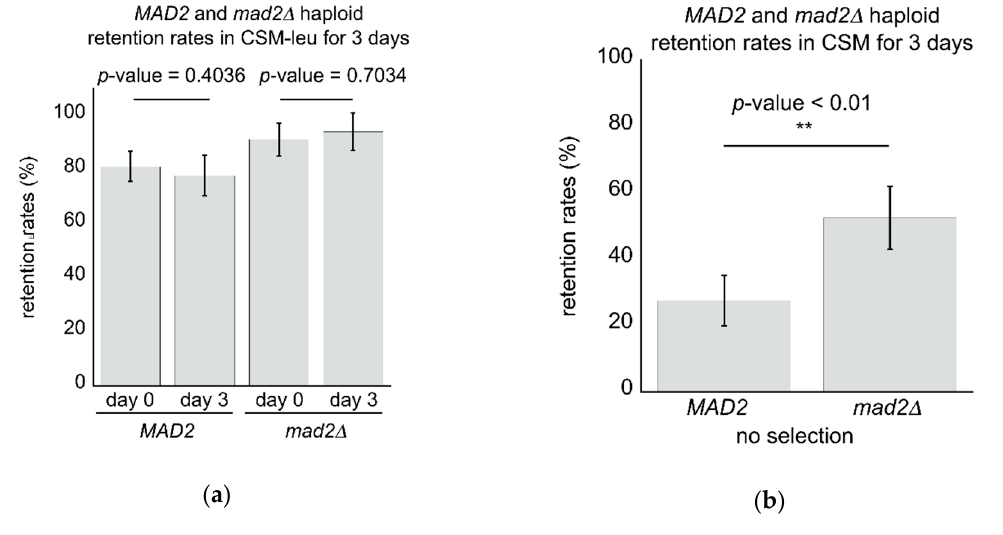
Figure 5. Mutant mad2 ∆ cells display a higher retention rate compared to wild type MAD2 cells even in the absence of auxotrophic selection: ( a ) After 3 days of growth in selective CSM-leu media no significant change in retention rates were observed in either wild type MAD2 or mutant mad2 ∆ cells; ( b ) By contrast, in cells grown for 3 days in CSM in the absence of selection, mad2 ∆ cells displayed a significantly higher retention rate for the artificial linear chromosomes ( p -value < 0.01 denoted by **, Student’s t -test).